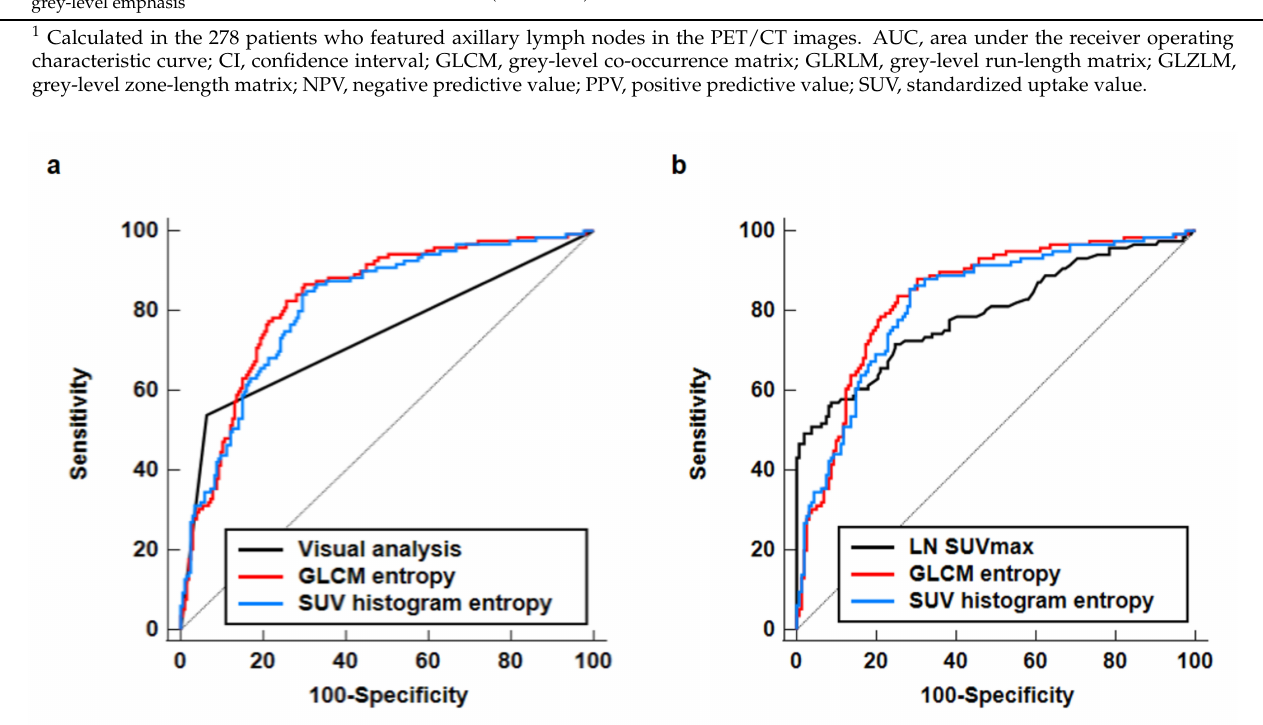
Figure 4. Comparison of the receiver operating characteristic curves for grey-level co-occurrence matrix entropy (GLCM entropy) and standardized uptake value histogram-based entropy (SUV histogram entropy) of peritumoral breast adipose tissue and visual analysis of PET/CT ( a ). Comparison of the receiver operating characteristic curves for GLCM entropy and SUV histogram entropy of peritumoral breast adipose tissue and the maximum SUV of the axillary lymph node (LN SUVmax) ( b